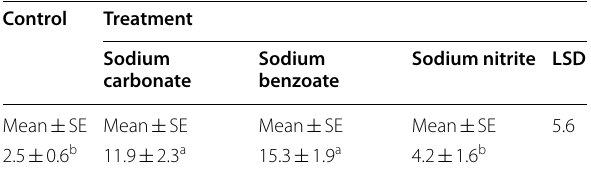
Table 3 Effect of ½ LC of three inorganic salts on lipid 50 proxidase (LPO) activity (nmol/ g) tissues in land snail, Massylaea vermiculata